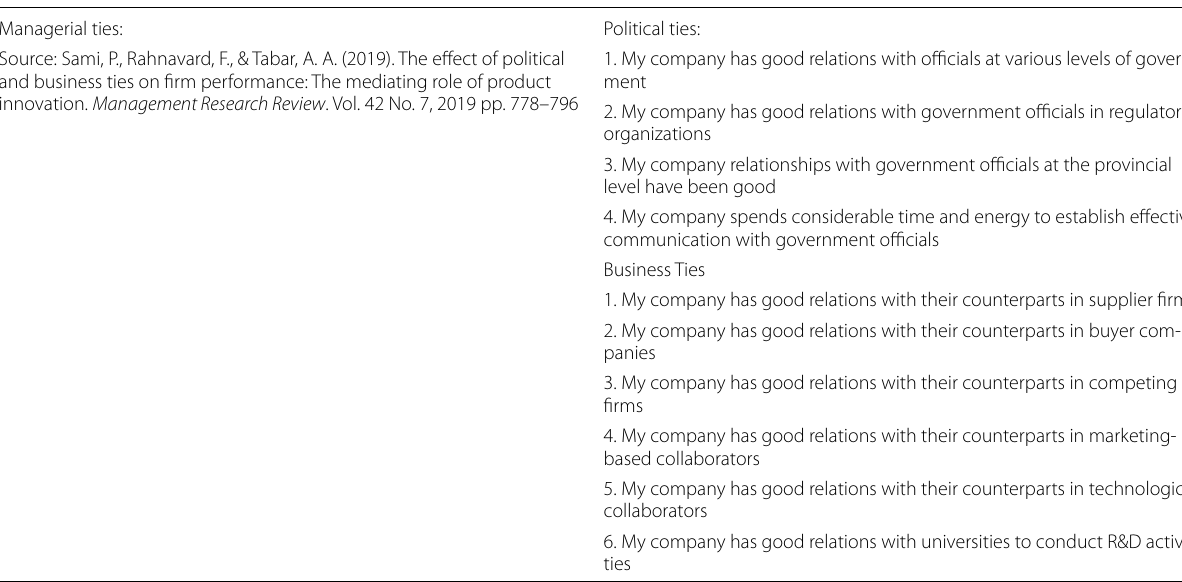
Table 6 Scales measuring Study model variables and their sources Managerial